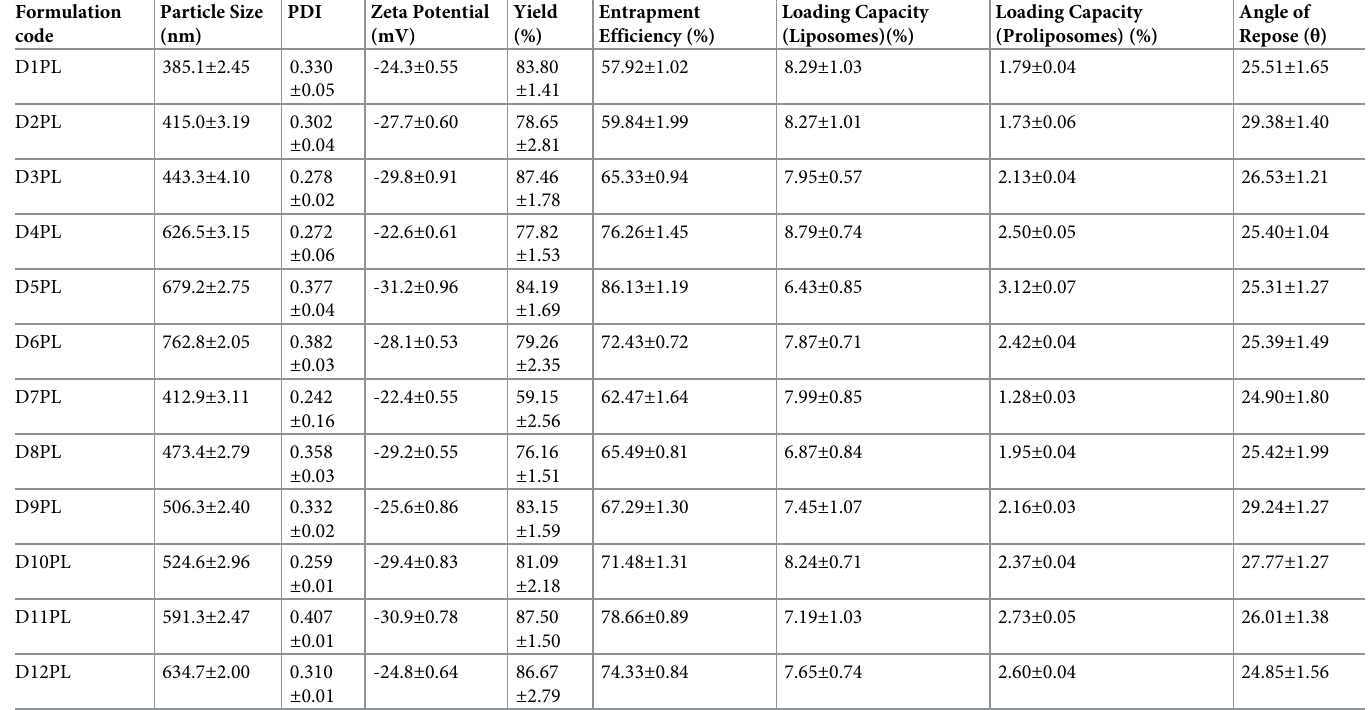
Table 2. Evaluation of different parameters of proliposomal formulations. Formulation code